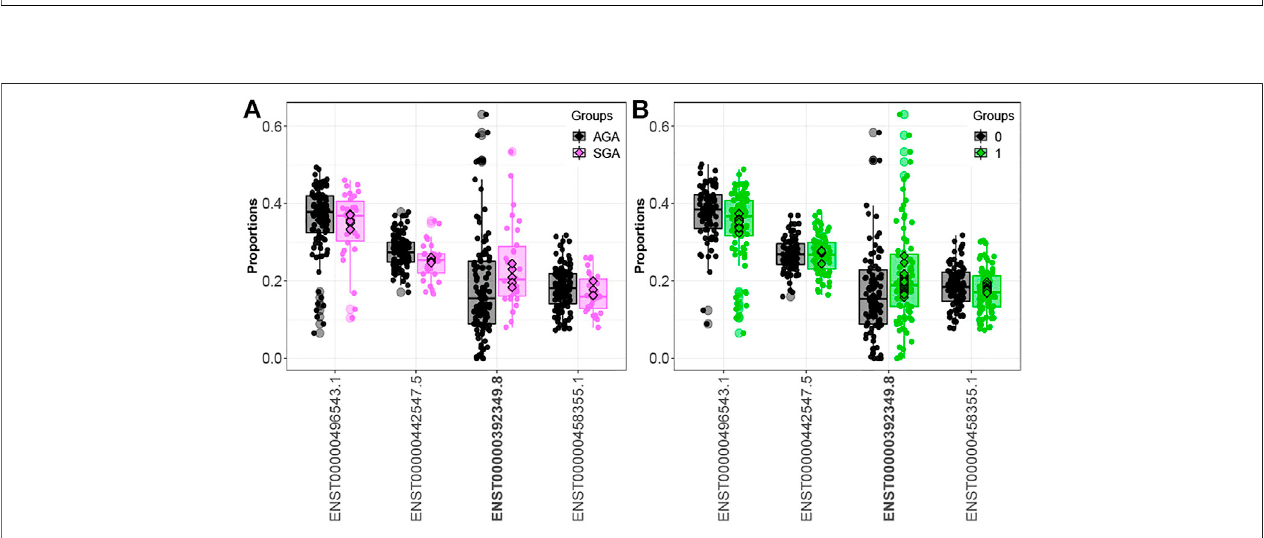
FIGURE 2 | ORMDL1 differential transcript usage. Elevated expression of the ORMDL1 transcript ENST00000392349.8 is observed in SGA infants compared to AGA infants (A) and infants above vs. below the median fetal exposure to arsenic (B) .